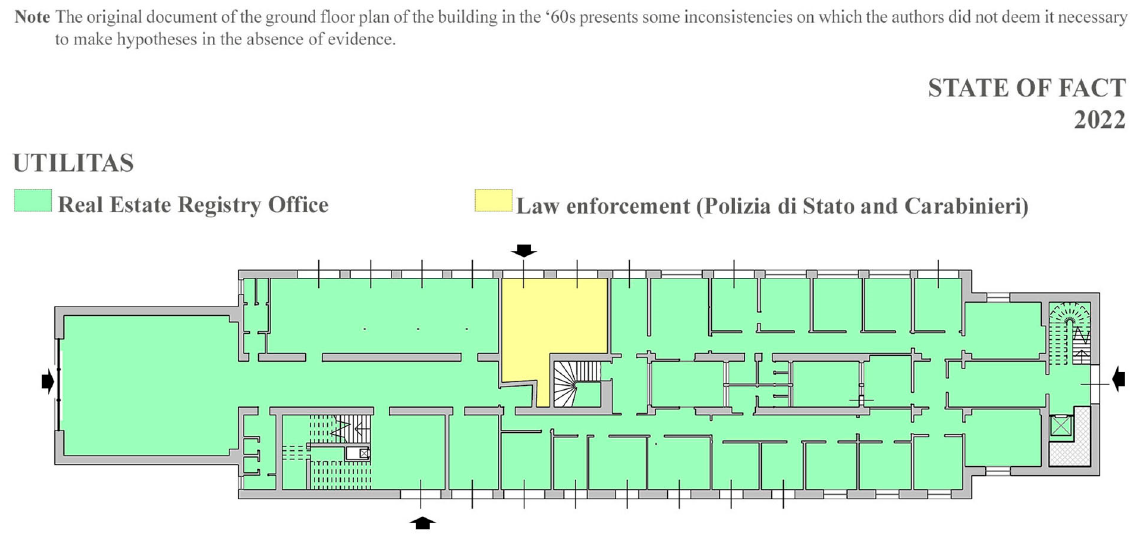
Figure 16. The model historicisation to document the variation of utilitas of the former Fascist House. The exempli fi cation for the ground fl oor.